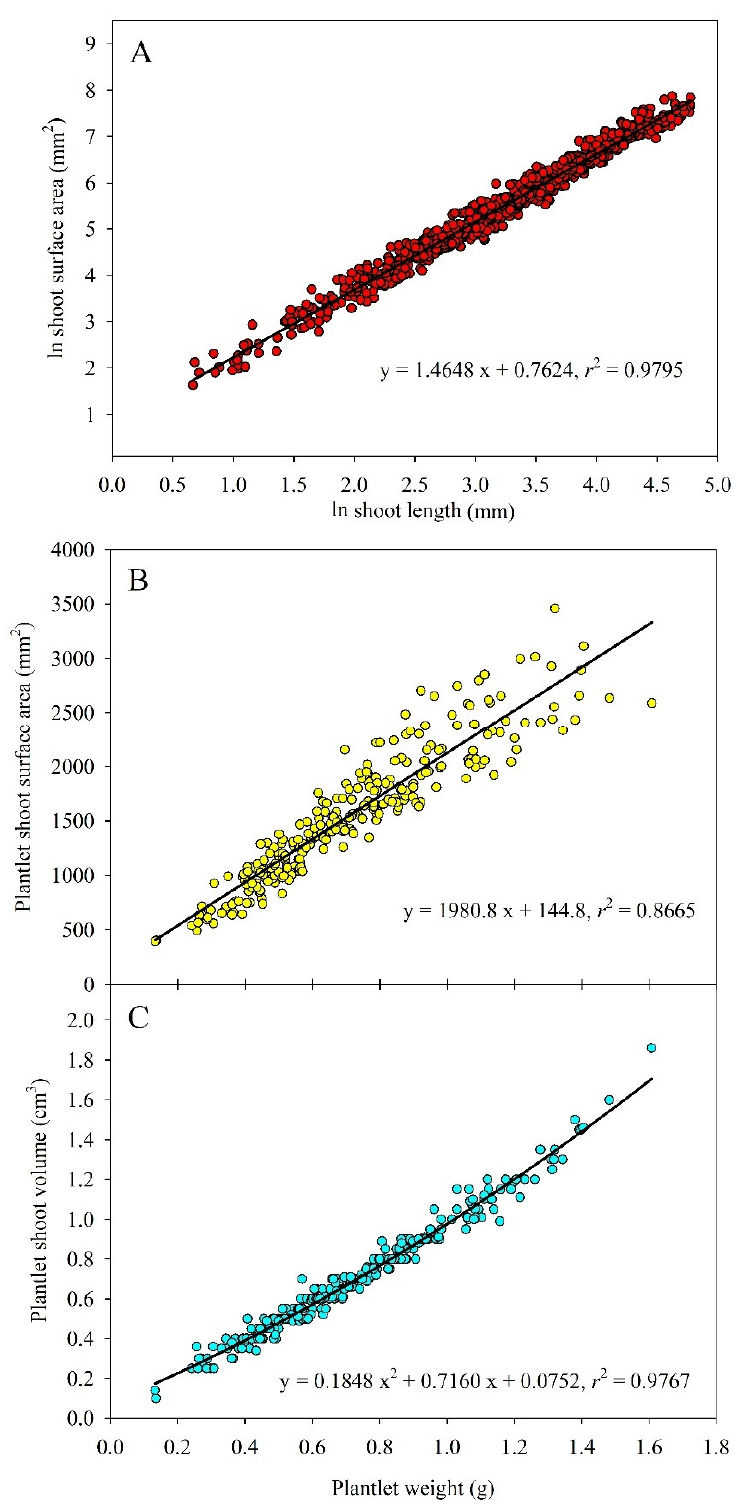
Figure 8. Relationships ( A ) between (regeneration) shoot surface area and (regeneration) shoot length, ( B ) between plantlet weight and plantlet surface area, and ( C ) between plantlet weight and plantlet volume on Hylocereus polyrhizus ‘Da Hong’. The regression equations were: ( A ) y = 1.4648x + 0.7624 ( n = 808, r 2 = 0.9795, p < 0.0001), ( B ) y = 1980.8x + 144.8 ( n = 270, r 2 = 0.8665, p < 0.0001), ( C ) y = 0.1848x 2 + 0.7160x + 0.0752 ( n = 270, r 2 = 0.9767, p < 0.0001), respectively.